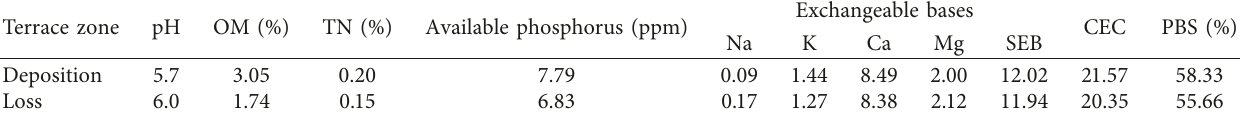
Table 2: Effects of terrace on Selected Soil properties [22].